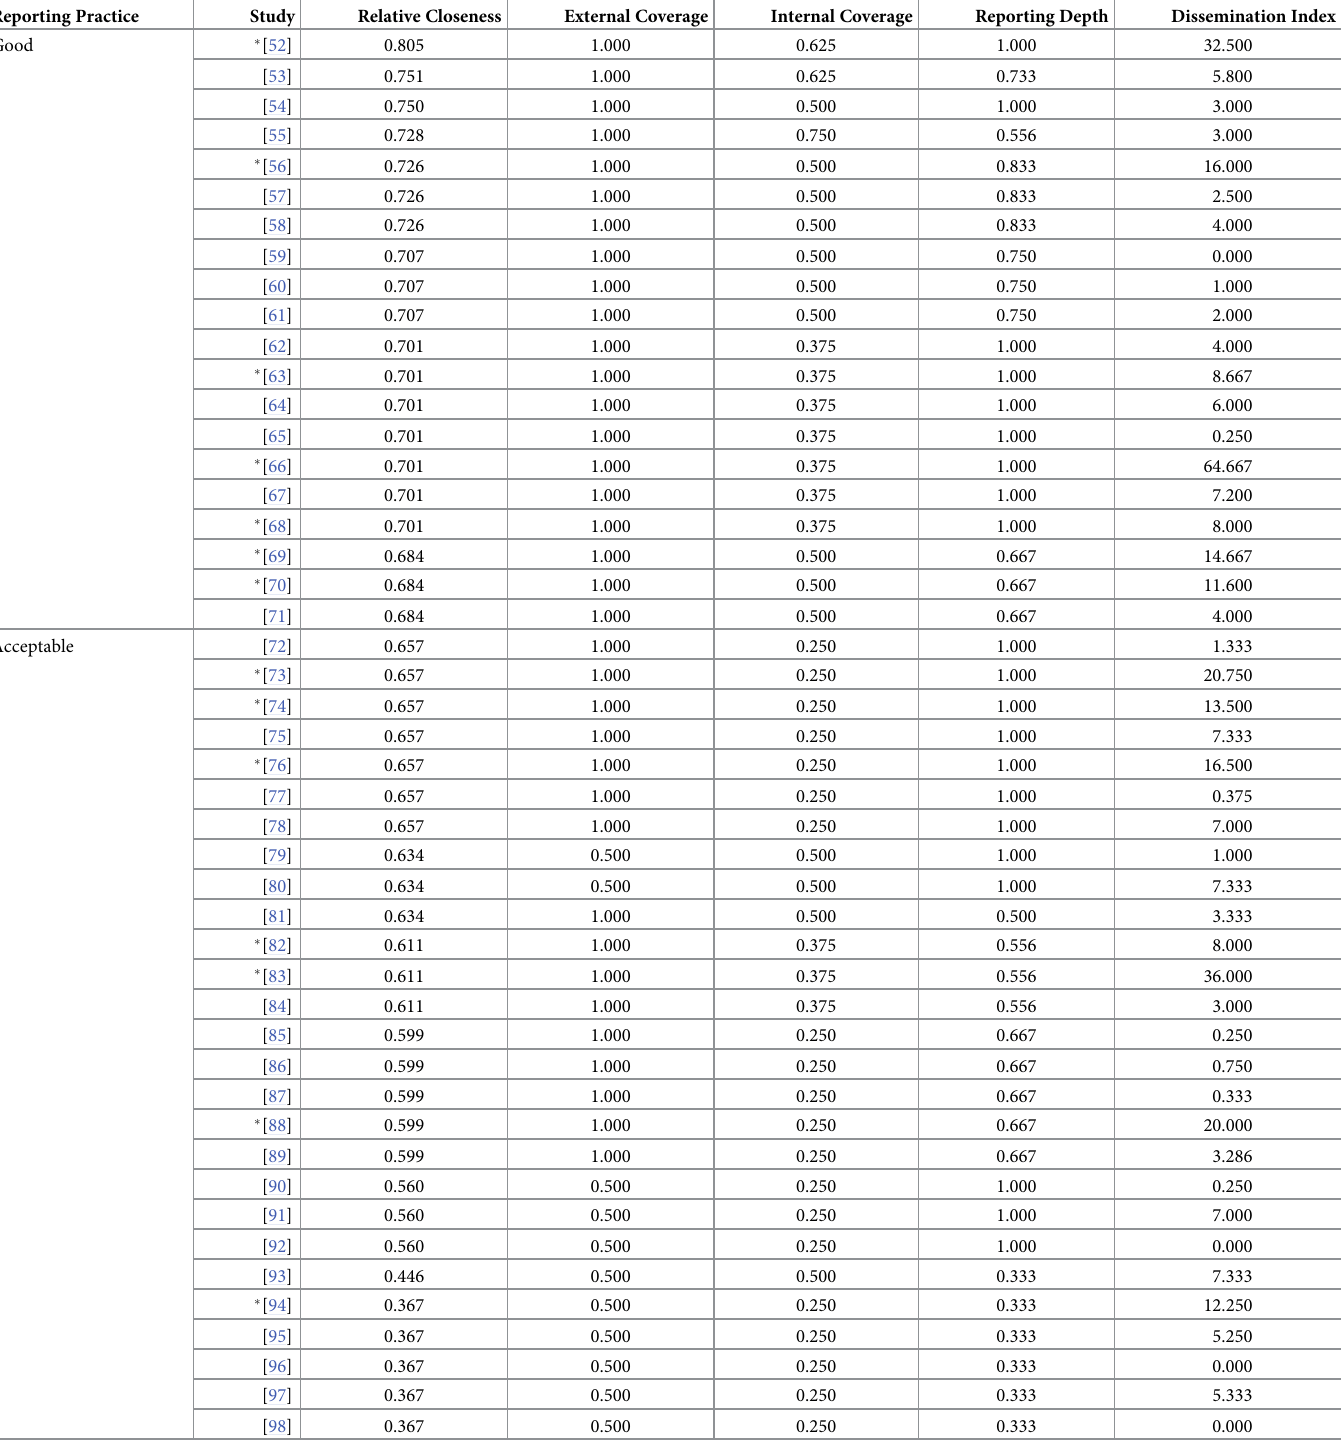
Table 5. Studies ranked by their Relative Closeness to the ideal study in terms of reporting practices of quality